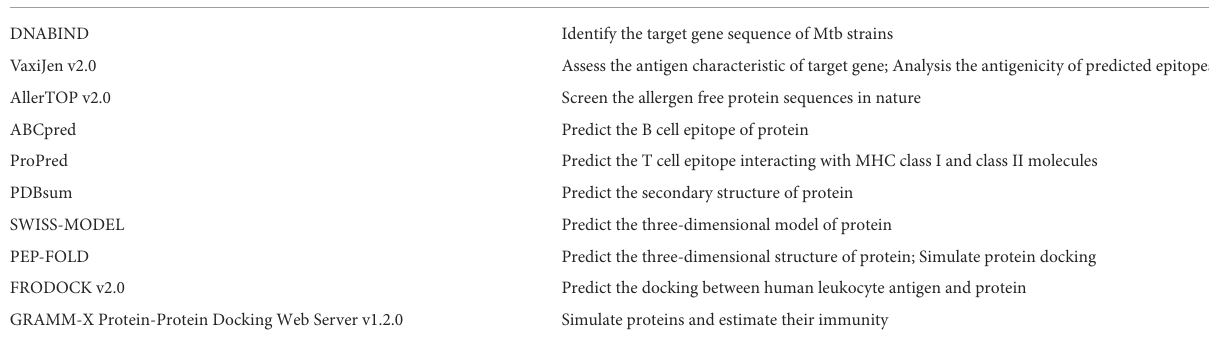
TABLE 3 Summary of common immunoinformatic tools. Tool DNABIND VaxiJen v2.0 AllerTOP v2.0